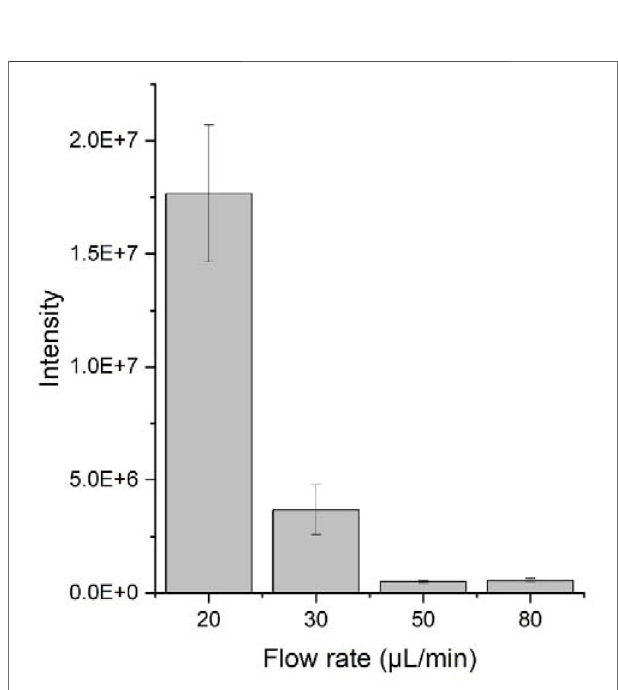
Frontiers in Chemistry |